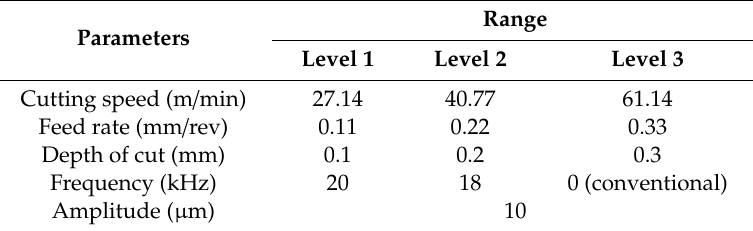
Table 3. Range and levels of process parameters.